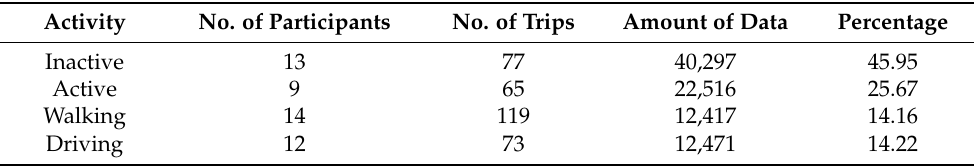
Table 2. Amount of data with respect to